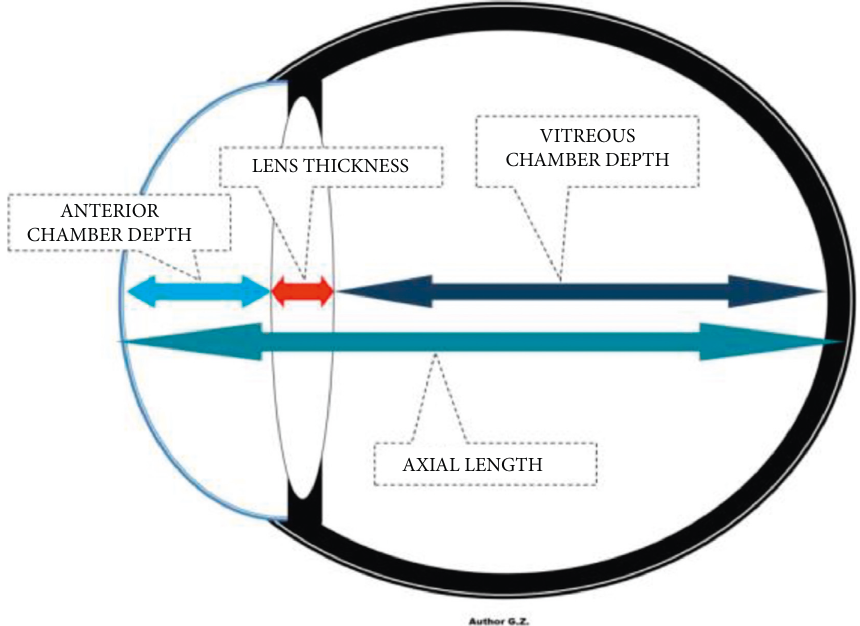
Figure 1: The axial length of the eyeball.